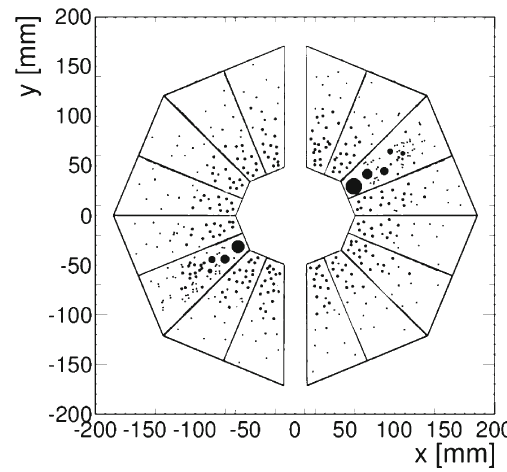
Fig. 9 CASTOR’s simplified cross section scheme with an example of detection of one coplanar interaction. The larger the circle size, the higher the energy of the particle